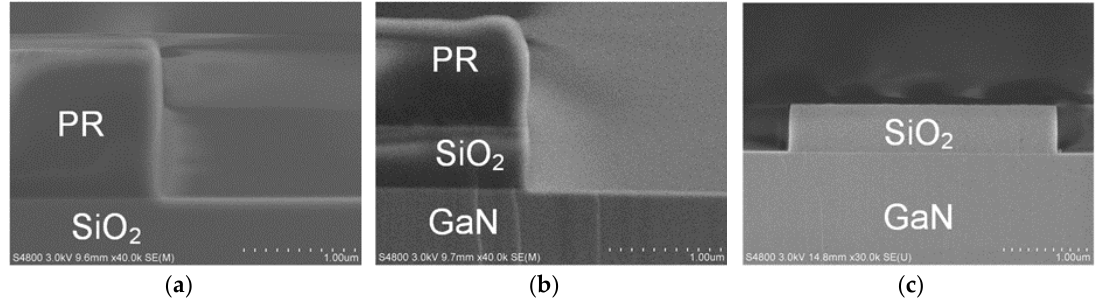
Figure 5. Cross SEM images of the sidewall of (a) photoresist (AZ5214E) and of (b) SiO 2 hard mask with PR on top and ( c ) without PR.